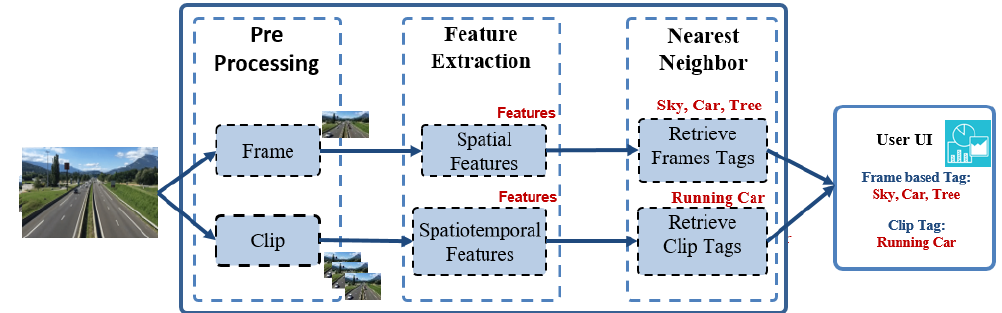
Figure 2. End-to-end flow diagram of the proposed spatiotemporal-based video annotation